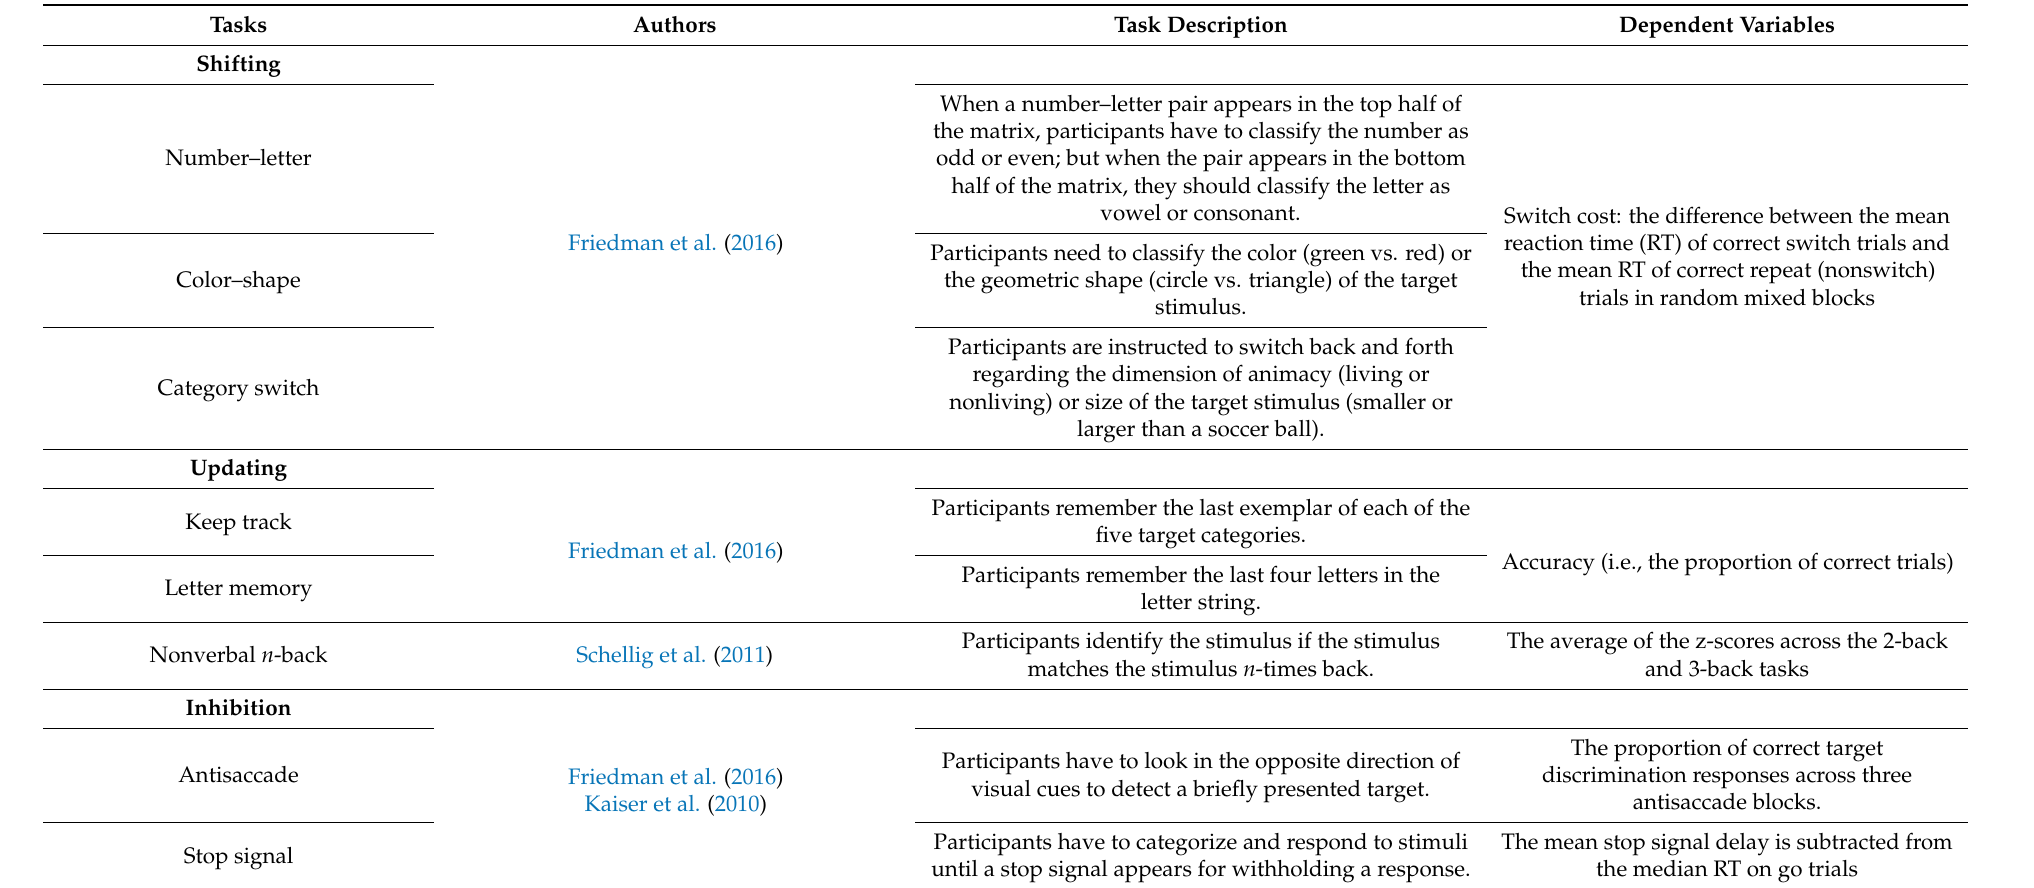
Table 1. A short description of the